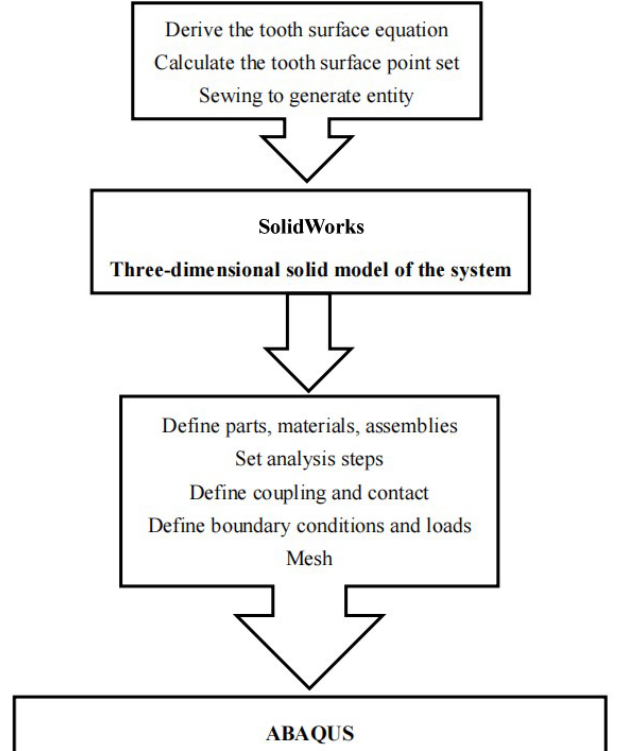
Figure 10. The modeling process.